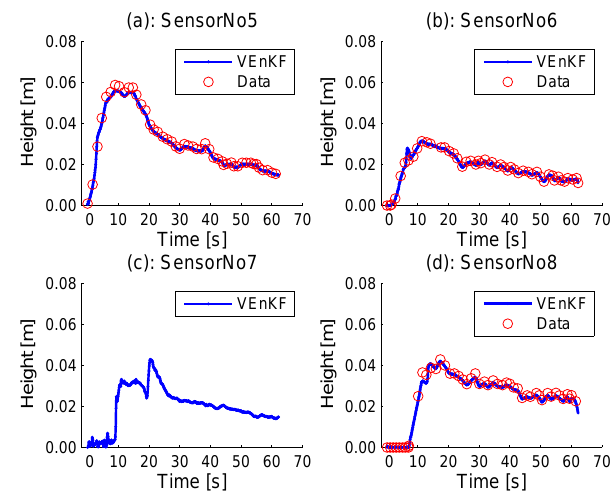
Fig. 12. Experiment 2: Comparison of VEnKF results and measured depth of the dam break experiment for the last four sensors at the downstream end. Sensor No. 7 did not have